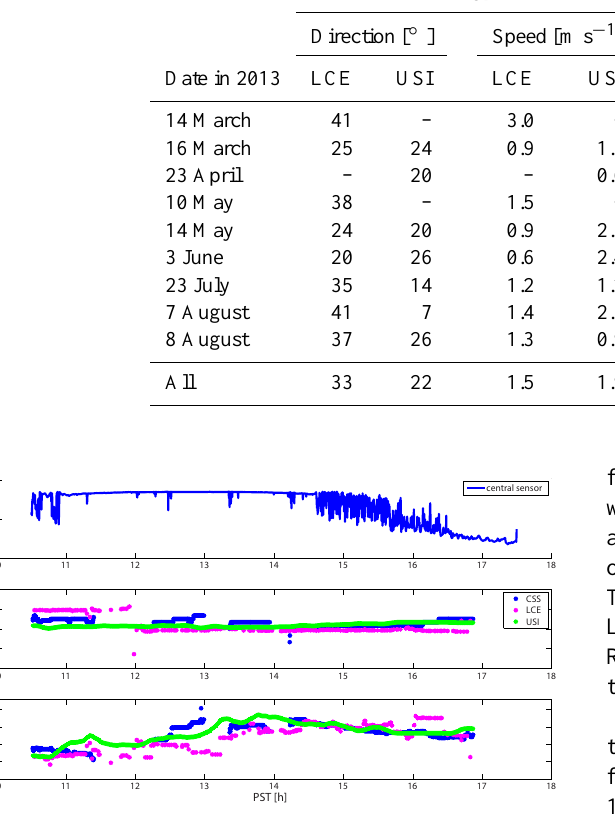
Figure 7. Solar irradiance and CMVs detected during the CSS de- ployment on 8 August